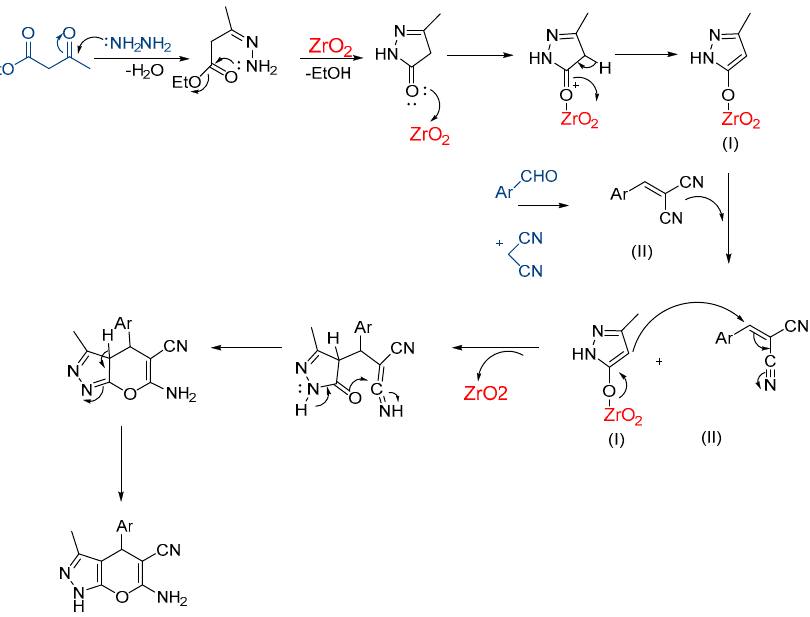
Scheme 3. Proposed mechanism for the multi-component synthesis of